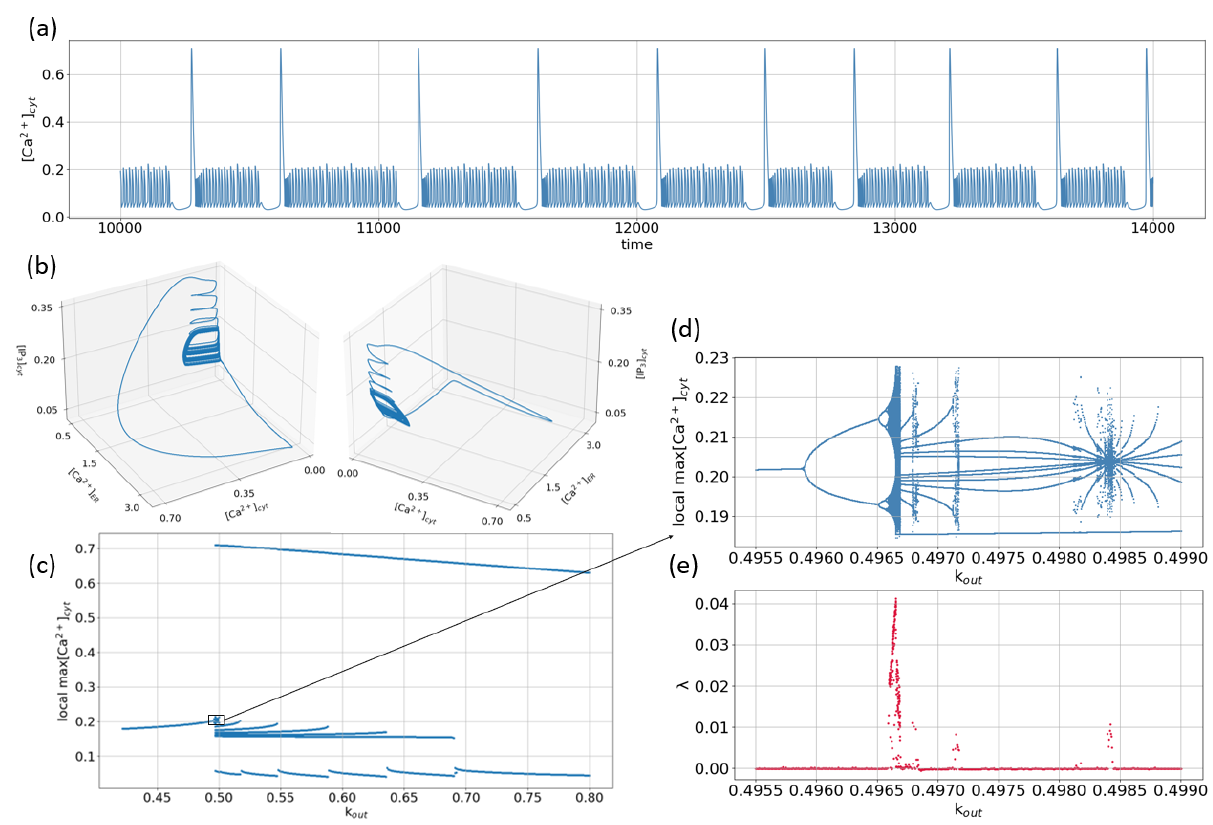
Figure 6. ( a ) Time series of [ Ca 2 + ] cyt ; and ( b ) corresponding phase portraits obtained for J in = 0.05 µ M/s, v M 2 = 15 µ M/s, v M 3 = 40 s − 1 , v p = 0.05 µ M/s, k CaA = 0.27 µ M, k CaI = 0.27 µ M, k p = 0.164 µ M, k ip 3 = 0.1 µ M, k deg = 0.08 s − 1 , k out = 0.49668 s − 1 , k f = 0.5 s − 1 ; ( c ) One-parametric bifurcation diagram shows the local maxima of [ Ca 2 + ] cyt obtained for various values of the parameter k out within the time interval t ∈ [10,000, 15,000]; for each value of k out , the initial conditions are ( 0.1,1.5,0.1 ) ; ( d ) Enlargement of the squared part of the one-parametric bifurcation diagram given in ( c ); ( e ) The maximal Lyapunov exponent as function of the parameter k out